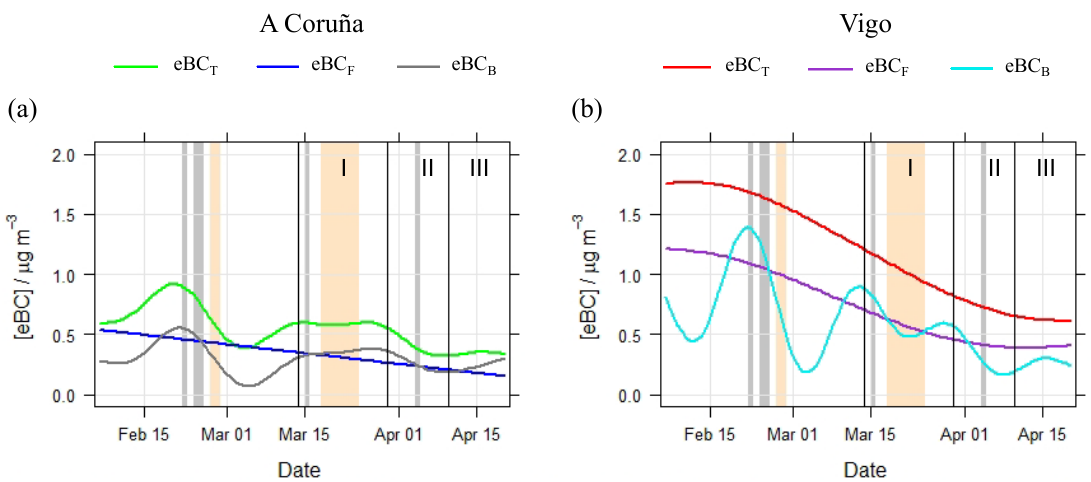
Figure 3. Concentration evolution of eBC T , eBC F , and eBC B (24 h mean) before and during the lockdown period. The left and right panels correspond to data obtained for air quality monitoring stations in the cities of A Coruña ( a ) and Vigo ( b ). The areas highlighted in gray and yellow show days with biomass combustion and Saharan dust intrusion, respectively. Time periods of lockdown stages (I, II, and III) are also delimited by vertical black lines.